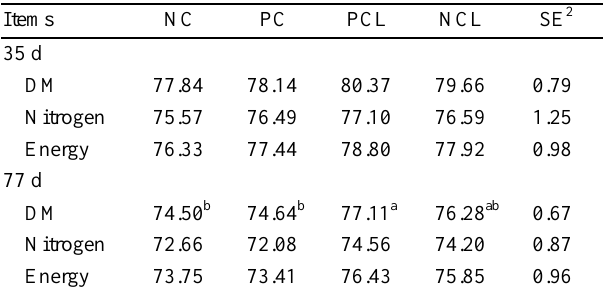
Table 3. Effect of low fermentable carbohydrates (FC) on nutrient